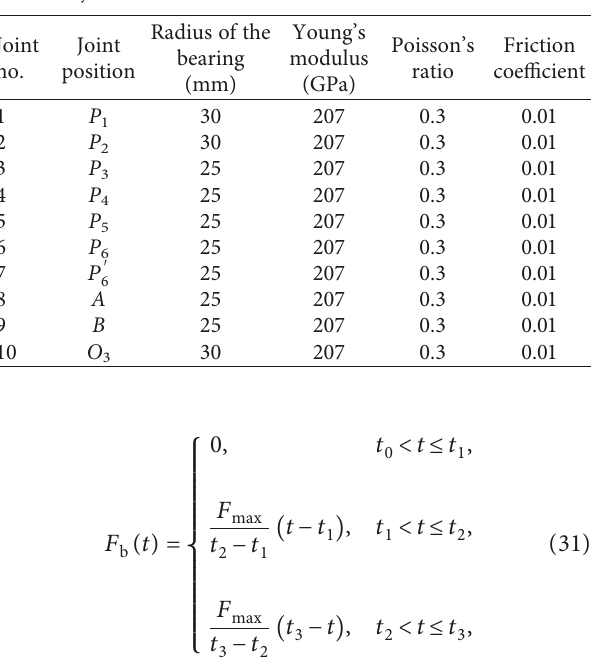
Table 4: Geometric and physical parameters of the revolute clearance joints.